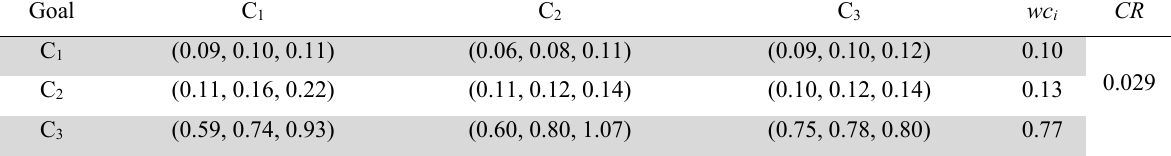
Table 5 The normalization of integrated pair-wise comparison matrix